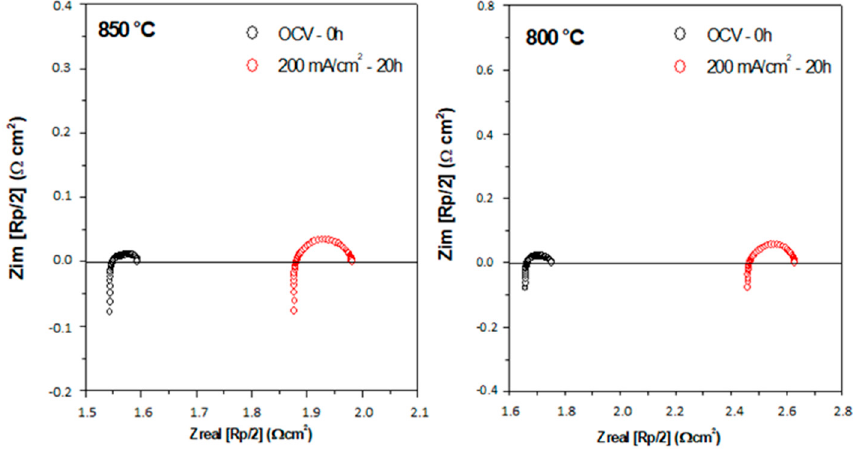
Figure 9. Impedance spectra of symmetrical cells under open circuit voltage (OCV) (0 h) and constant current density of 200 mA cm − 2 (20 h) at ( a ) 850 ° C and ( b ) 800 ° C.